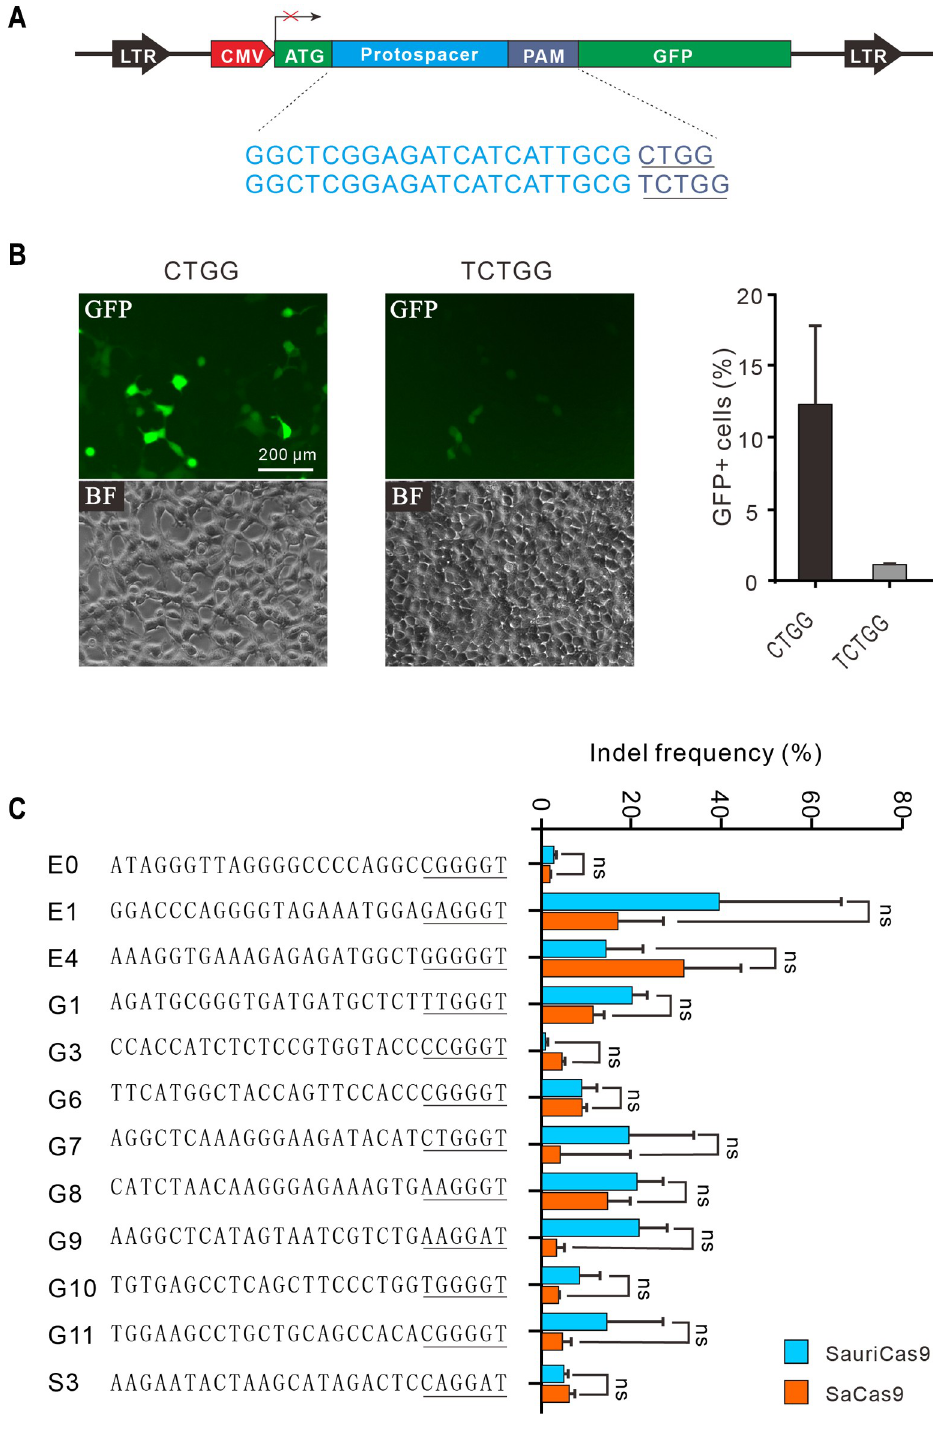
Fig 3. Genome editing capability of SauriCas9. (A) A GFP-reporter construct is used to compare the activity of NNGG and NNNGG PAMs. Target sequences are shown below. PAM sequences are shown in blue. (B) Transfection of SauriCas9 with gRNA resulted in GFP expression. Quantification is shown on the right. Underlying data for all summary statistics can be found in S1 Data. (C) Genome editing with SauriCas9 and SaCas9 for 12 endogenous loci. PAMs are underlined ( n � 2). Underlying data for all summary statistics can be found in S1 Data. GFP, green fluorescent protein; gRNA, guide RNA; PAM, protospacer adjacent motif; SaCas9, S . aureus Cas9; SauriCas9, Cas9 nuclease from S . auricularis